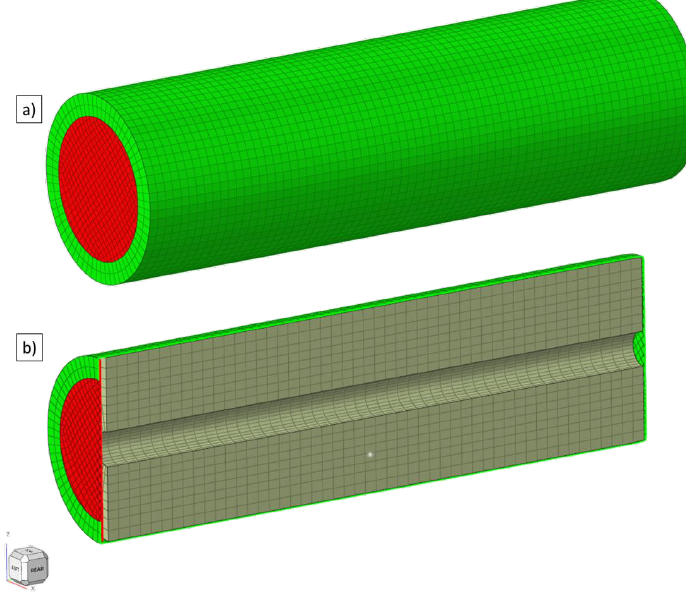
Figure 14. Entire FEM model ( a ), and vertical section cut ( b ).